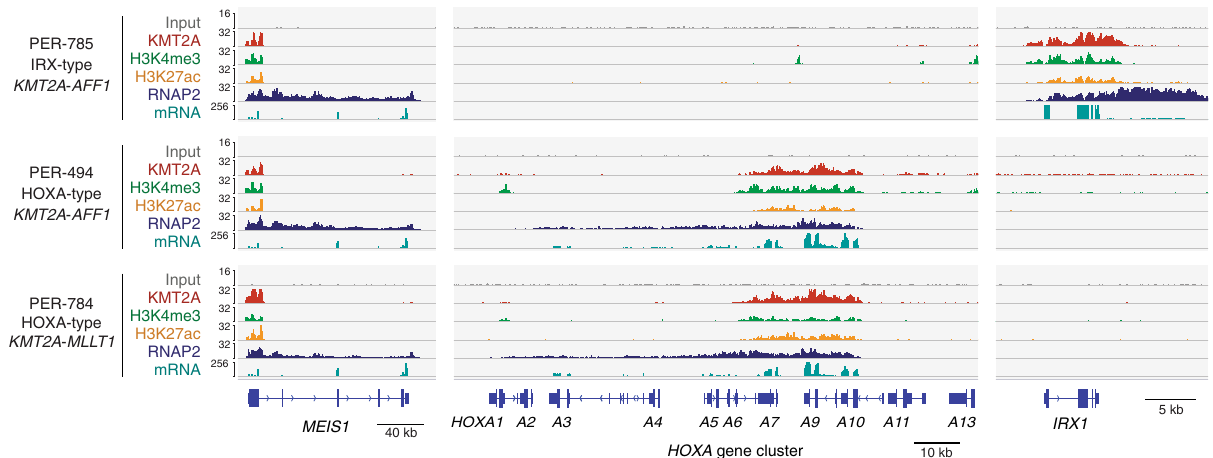
Fig. 6 | Different chromatin landscapes of IRX and HOXA subtypes of KMT2A -r infant ALL cell lines. ChIP-seq pro fi les of KMT2A, H3K4me3, H3K27ac, and RNA polymerase II (RNAP2) at the MEIS1 , HOXA , and IRX1 loci. RNA sequencing pro fi les are also